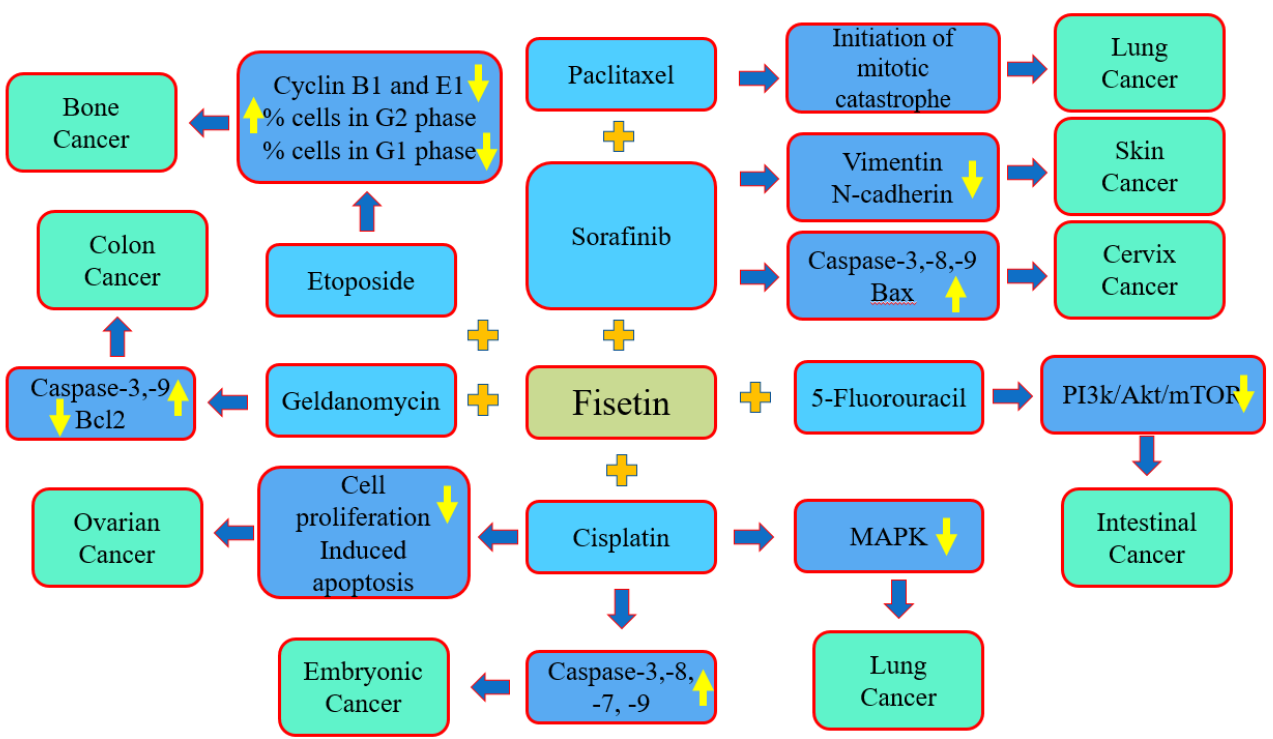
Figure 5. Synergistic role of fisetin with cancer drugs/natural compounds. Up arrow ( ↑ ) indicates upregulation, and downarrow ( ↓ ) indicates downregulation. The plus sign (+) sign indicates combination of two compounds.